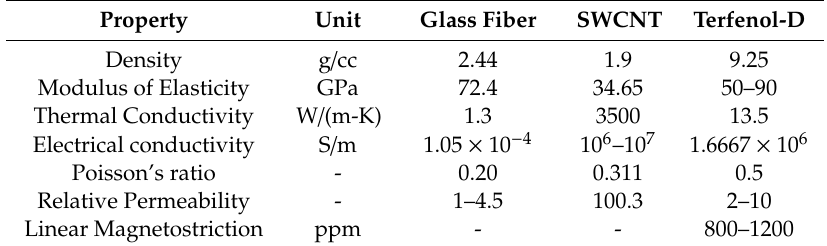
Figure 2. Smart self-sensing composite ( a ) labeled layer model and ( b ) model after running mesh. Table 1. Materials used on the COMSOL Multiphysics ® model and their